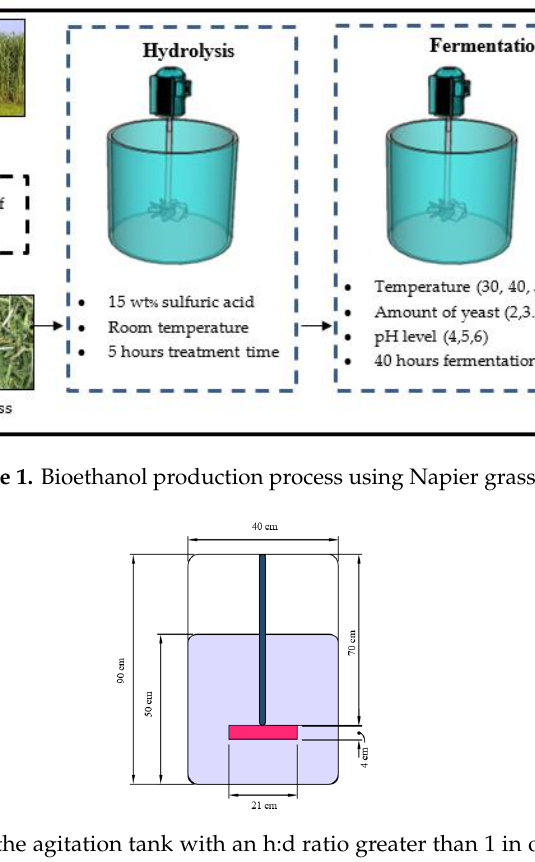
Figure 2. Dimensions of the agitation tank with an h : d ratio greater than 1 in order to optimize the vortex depth.